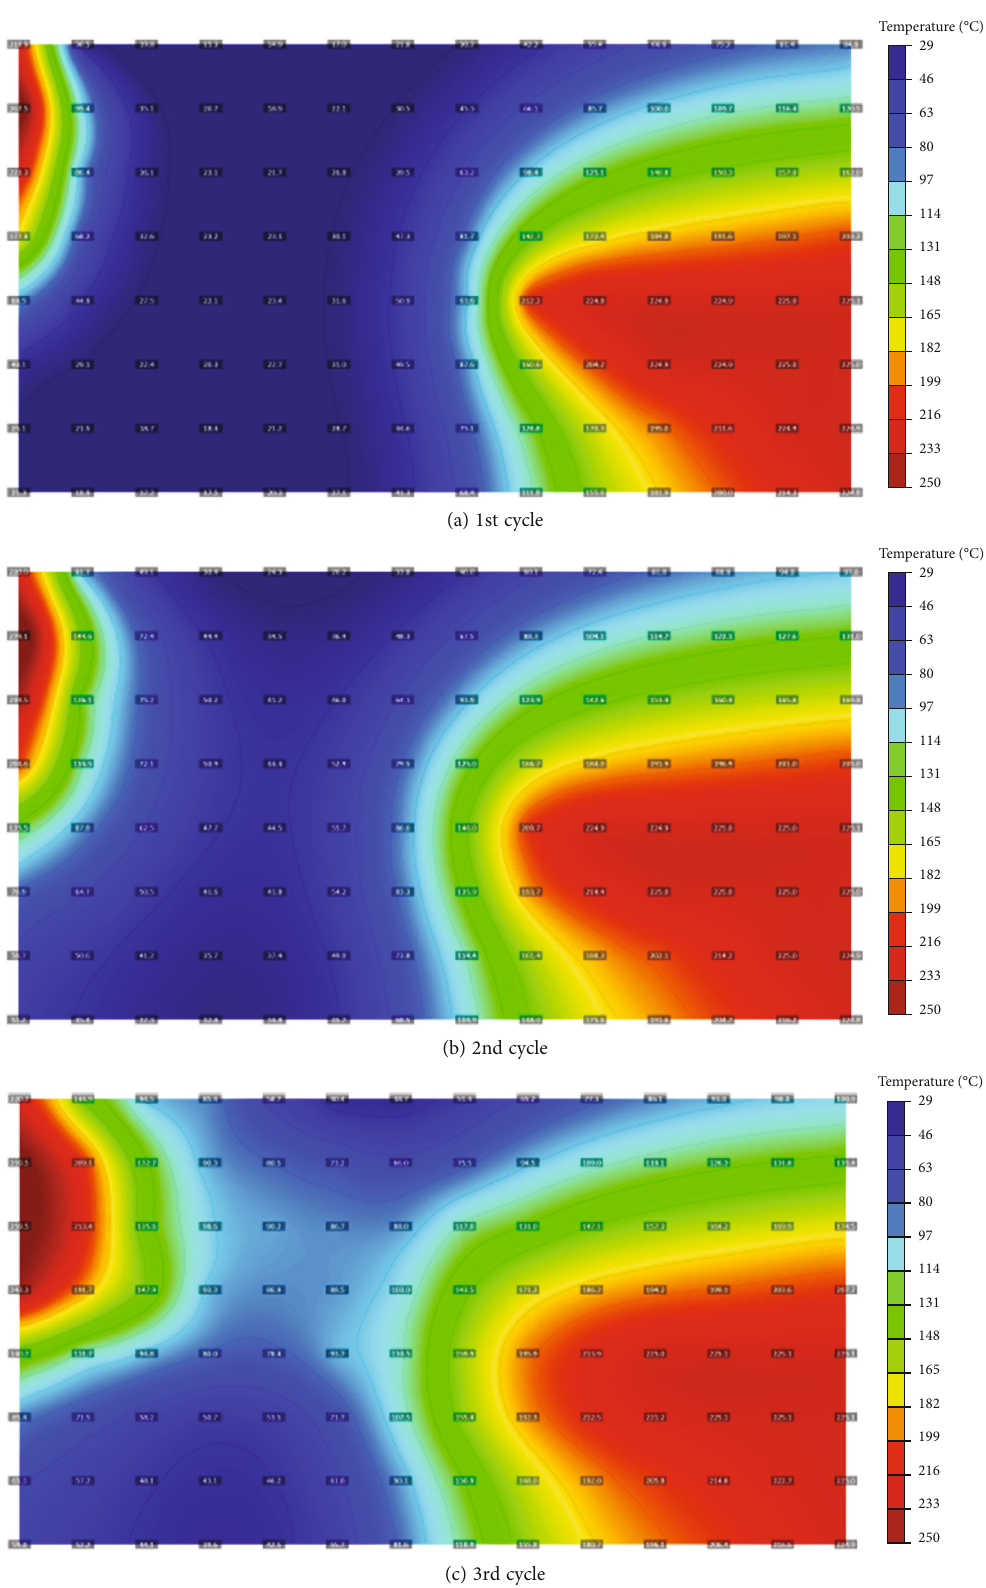
Figure 9: Temperature distribution of di ff erent cycles of in fi lled